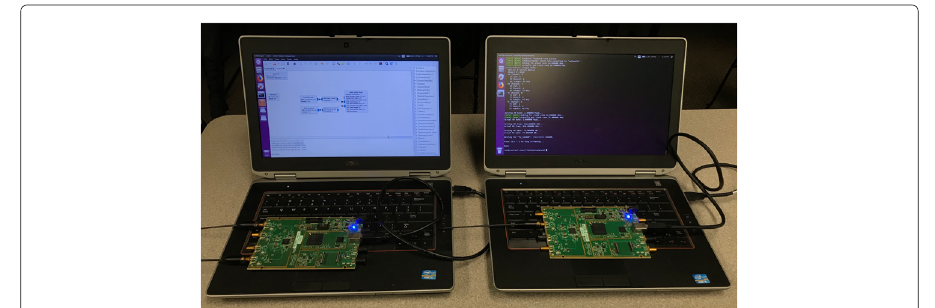
Fig. 3 The USRP B210 used in the experiments